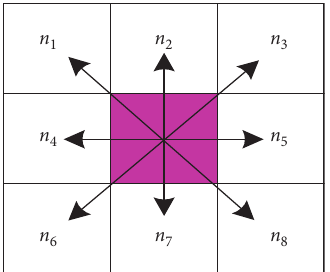
Figure 1: Schematic plot of the robot movement. Table 1: The relationship between angle ε and the discarded directions. ε Retained directions [337.5 ° , 360 ° ) ∪ [0 ° , 22.5 °